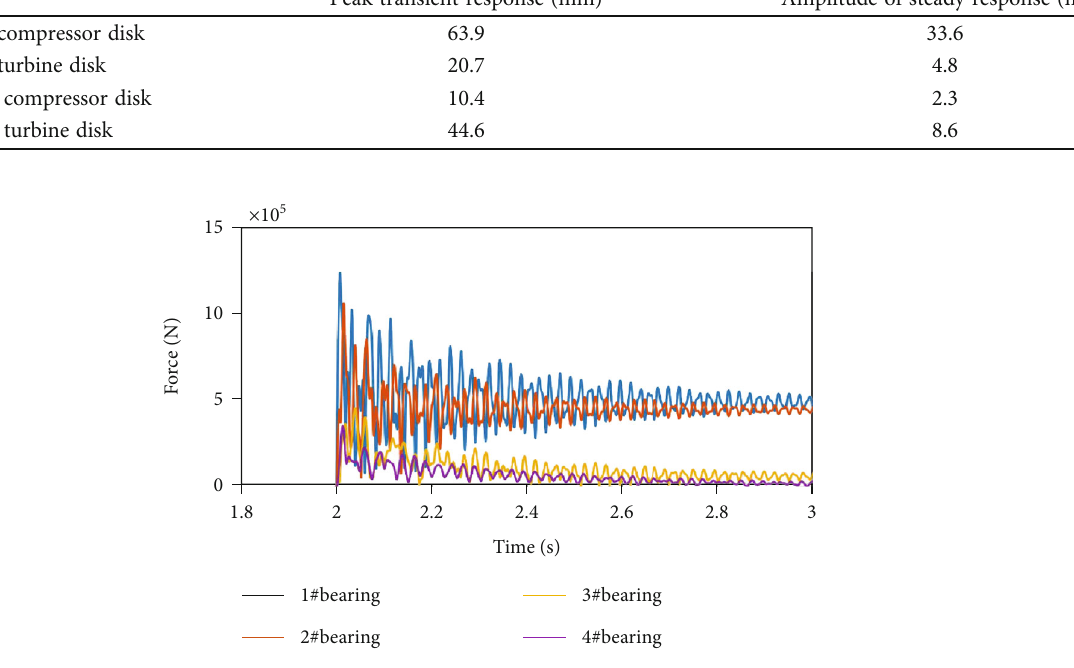
Figure 7: Reaction force of the simulated engine system. Table 5: Reaction force of support bearings.